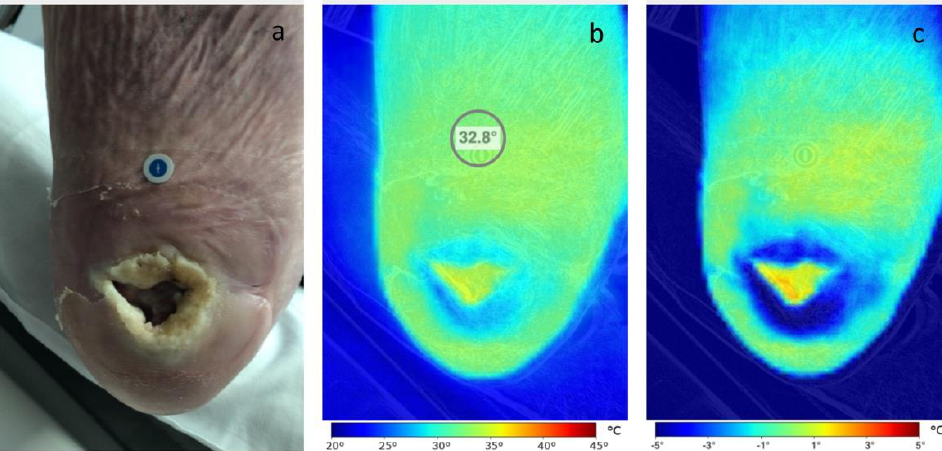
Figure 5. White light and thermographic images of the foot: ( panel a ) Anatomical (white light) image; ( panel b ) Absolute temperature color map, ( panel c ) Thermal gradient—relative temperature color map. A thermal gradient was generated with respect to the reference point displayed on the absolute temperature map. Images, courtesy of Dr. Jose L. Ramirez-GarciaLuna, were acquired using the Ray 1 (Swift Medical, Toronto, ON, Canada).